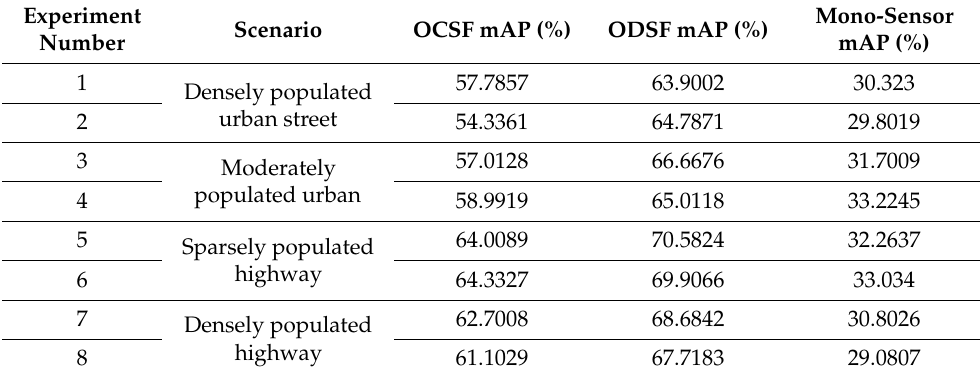
Table 8. mAP values for different videos for OCSF, ODSF, and mono-sensor